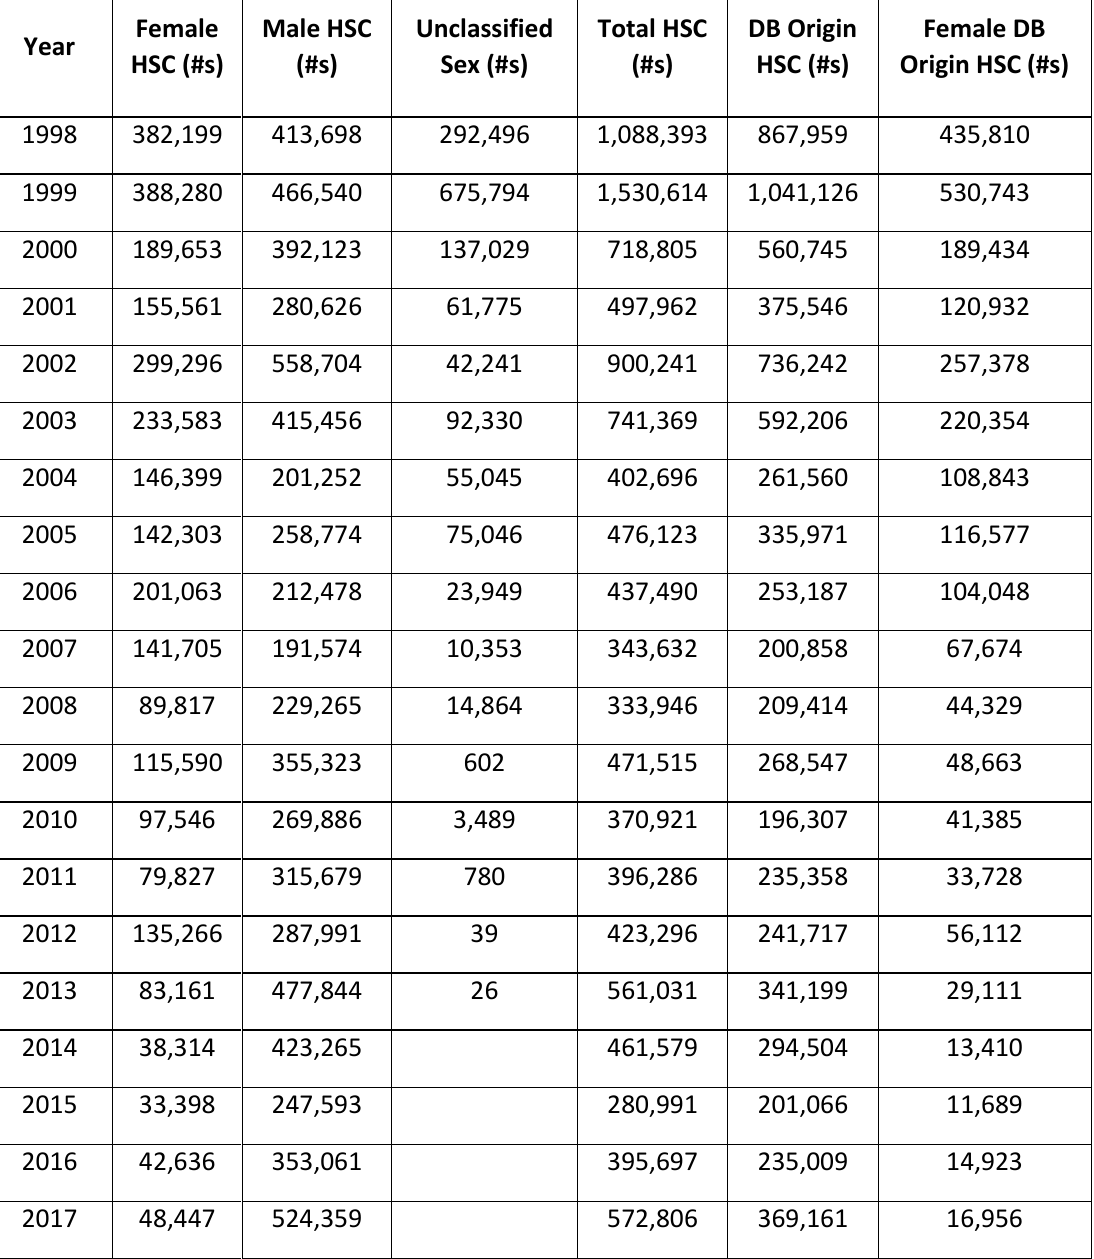
Table 14. Horseshoe crab commercial bait harvest in numbers for the Delaware Bay states by sex, 1998-2017, validated by ACCSP. The number of female horseshoe crabs of Delaware Bay origin was developed to support the catch survey analysis for that region. See section 4.1.3 for how these numbers were